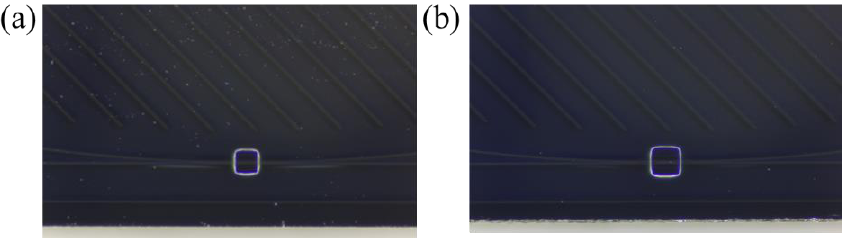
Figure 2. ( a ) The resonator with groove of 130 × 130 µm 2 ; ( b ) the resonator with groove of 160 × 160 µm 2 . According to the process characteristics, the parameters of the resonators are tested